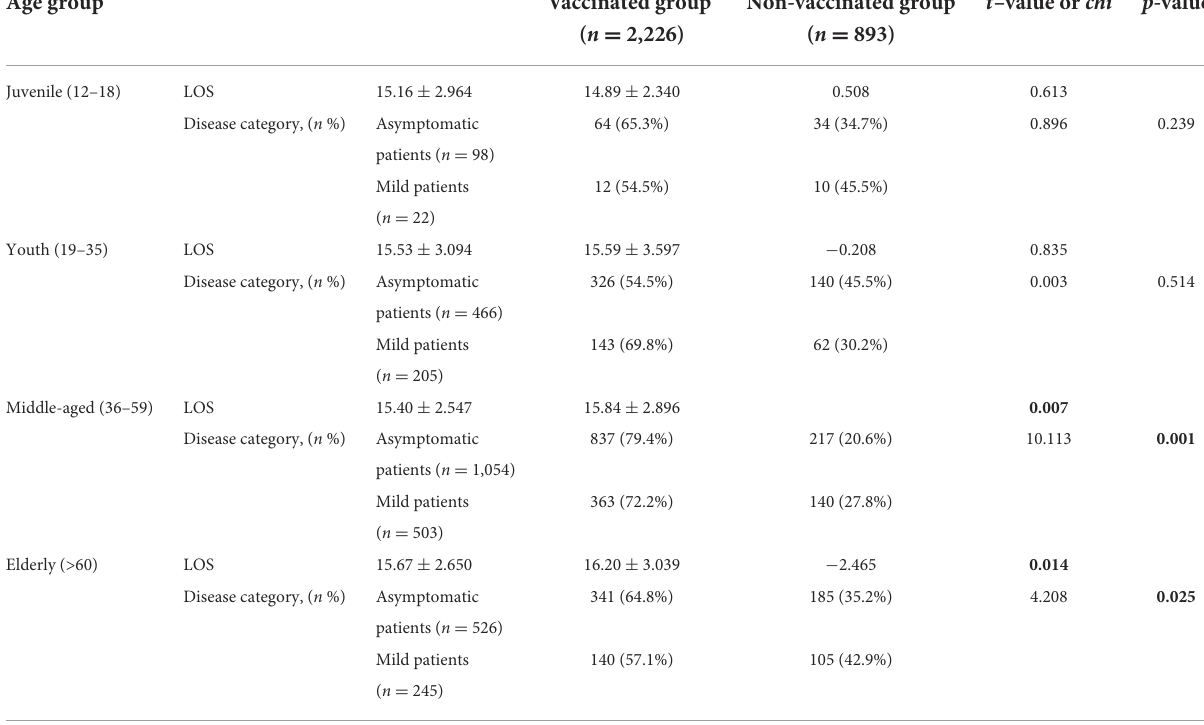
TABLE 3 Subgroup analysis for age group ( n =